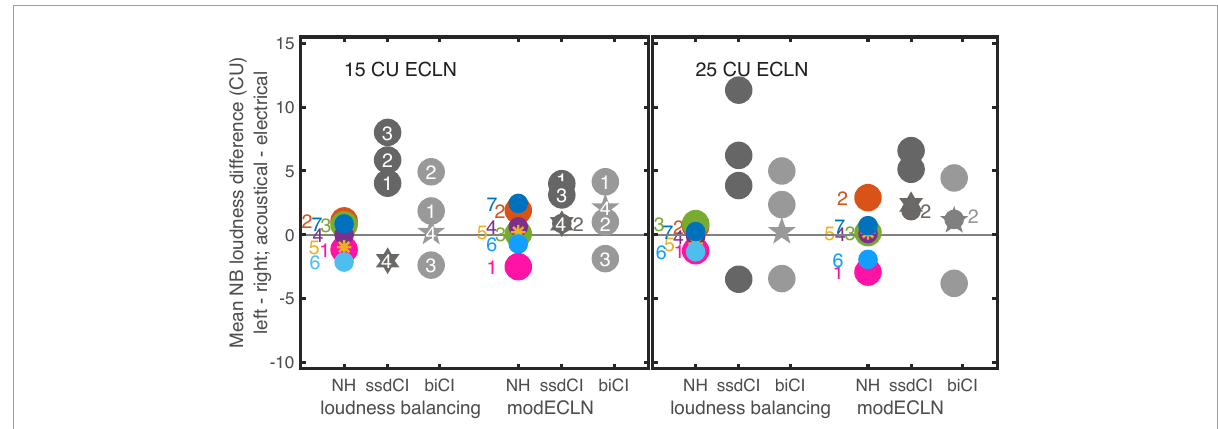
FIGURE9 Mean narrowband (NB) loudness difference that evoked 15CU (left panel) and 25CU (right panel) ECLN loudness on both ears. Right side of each panel shows the difference that is estimated by the modECLN procedure and left side shows the self-adjusted difference for the NH, uCI and biCI listeners. The numbers represent the individual listeners. The modECLN calculated nearly same NB differences for listener uCI2 and uCI4 at 15CU and listener biCI2 and biCI4 at 25CU ECLN